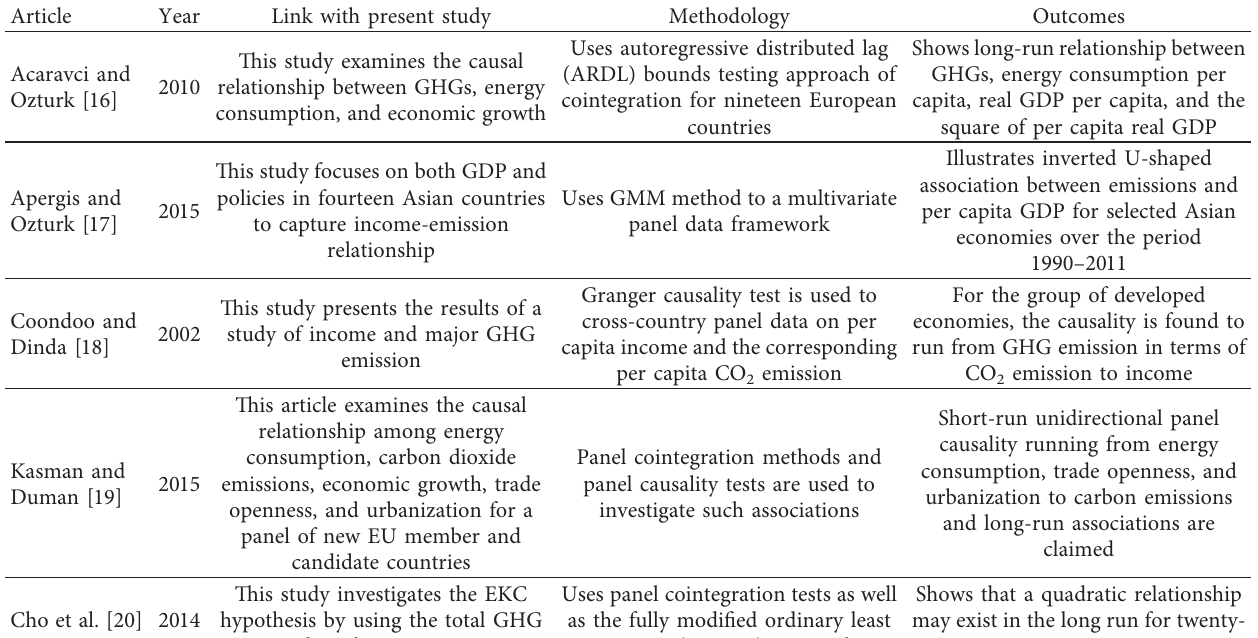
Table 1: List of relevant studies